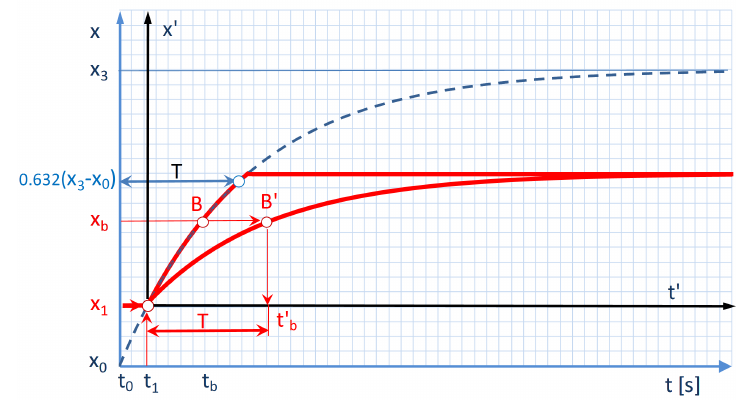
Figure 7. Illustration of the shift and scale